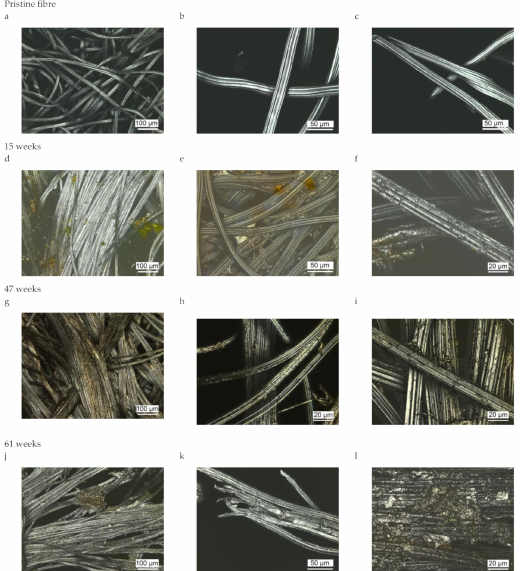
Figure 6. Photomicrographs of viscose fibres as function of time in outdoor weathering. ( a ) pristine CV fibres, ( b , c ) with use of higher magnification; ( d ) fibres after 15 weeks of outdoor weathering, ( e , f ) with use of higher magnification; ( g ) fibres after 47 weeks of outdoor weathering, ( h , i ) with use of higher magnification; ( j ) fibres after 61 weeks of outdoor weathering, ( k , l ) with use of higher